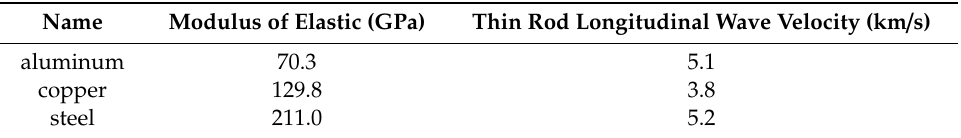
Table 1. The properties of aluminum, steel, and copper.